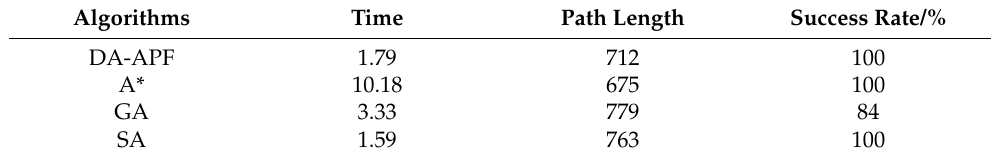
Table 2. Performance results for Environment II (mean values from 50 runs for all algorithms). Algorithms Time Path Length Success Rate/%